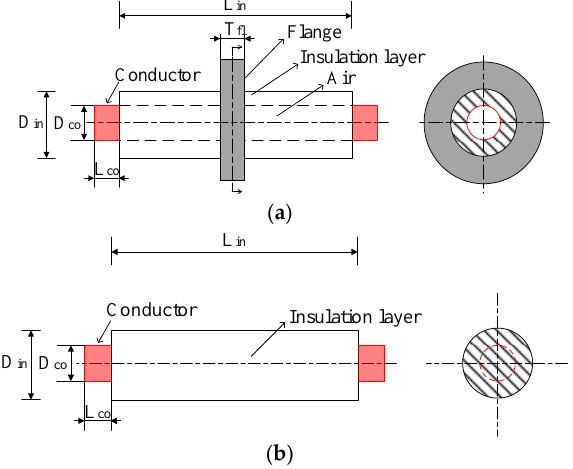
Figure 2. Orthographic view and central sectional map of samples with ( a ) bushing structure, and ( b ) post insulator structure. Table 1. Profile parameters of tested samples. Table 1. Profile parameters of tested